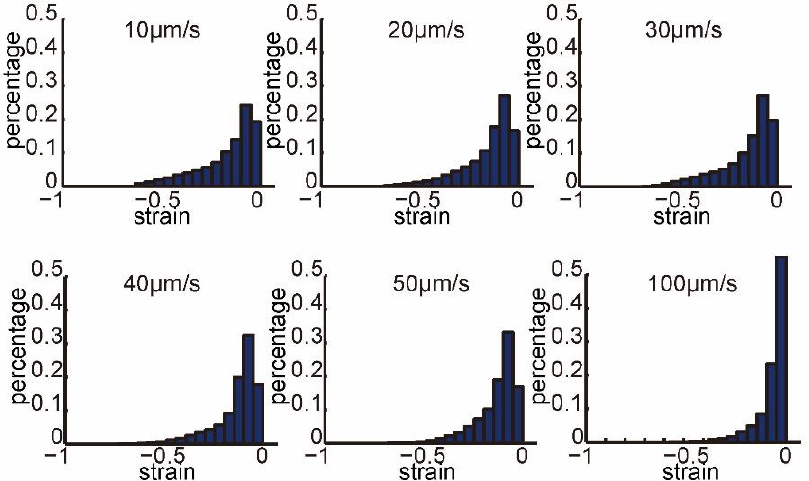
Figure 3. Normalized histograms of the strain field on all frames of 10 penetration processes at each penetration speed (penetration speed: 10, 20, 30, 40, 50, and 100 µ m/s).